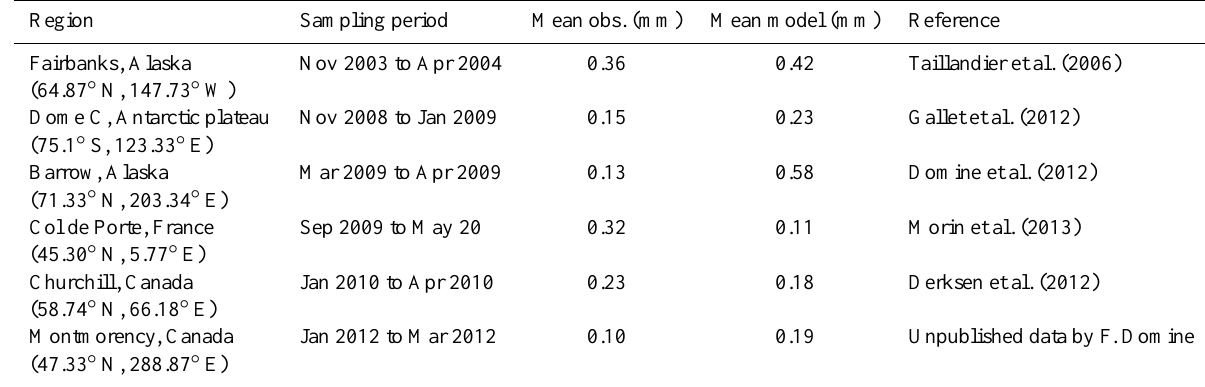
Table 1. Observed and simulated effective radii of snow in surface snow.